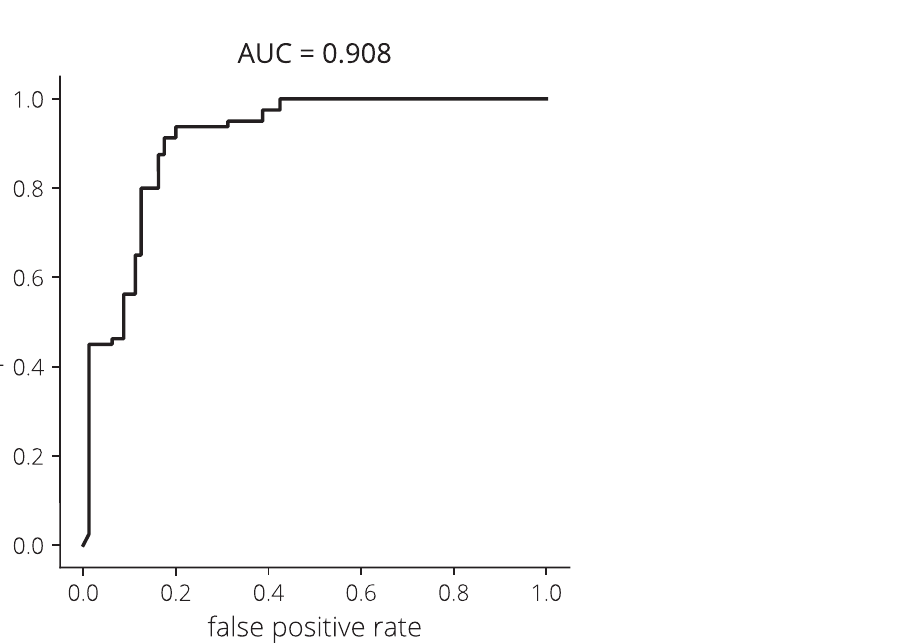
Fig 11. Receiver operating characteristic (ROC) curve for the CNN. The area under the curve (AUC) equals 0.908.